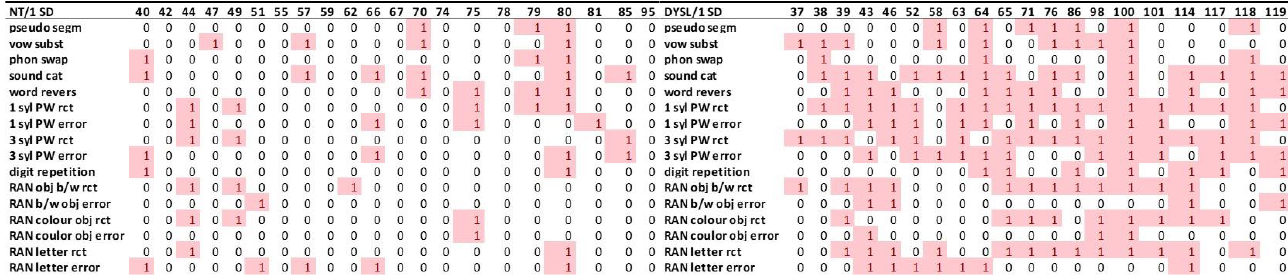
Figure 7. Deviating individual performance/phonology/subtest level. NT: neurotypical normal reading children, DYSL: children with dyslexia (numbers in the head row depict the individual subject), rct: reaction time, err: errors, Phon Mean: mean of the phonological subtests for phonological processing in an inner sense, syl: syllables, PW: pseudowords, RAN: rapid naming, b/w: black and white, obj: object.